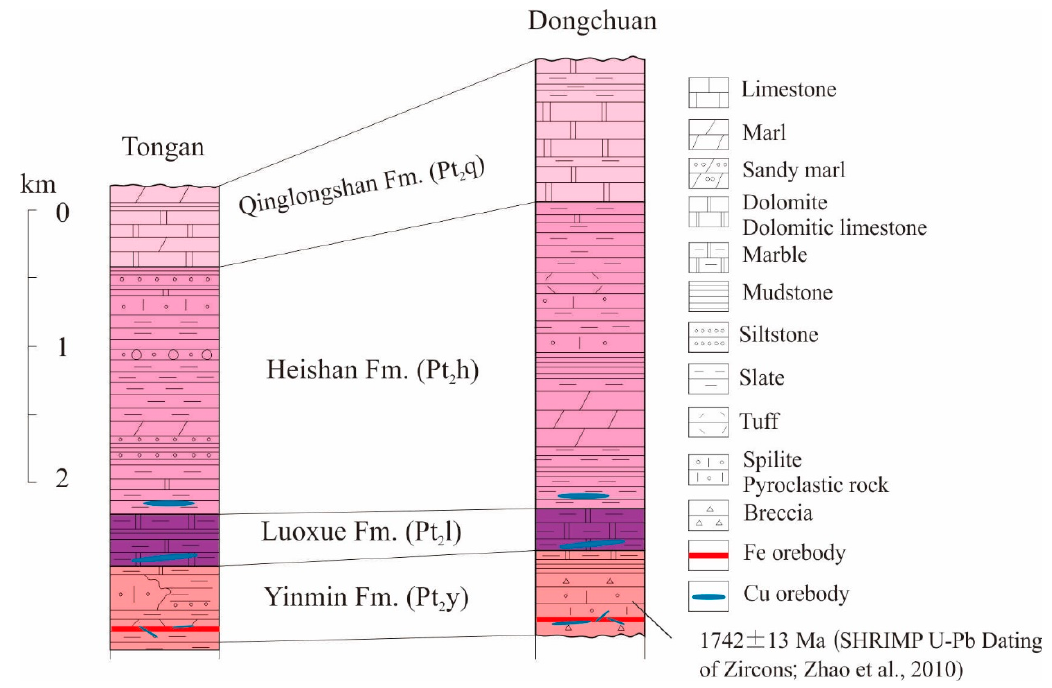
Figure 2. Stratigraphic comparison of Tongan–Dongchuan area.